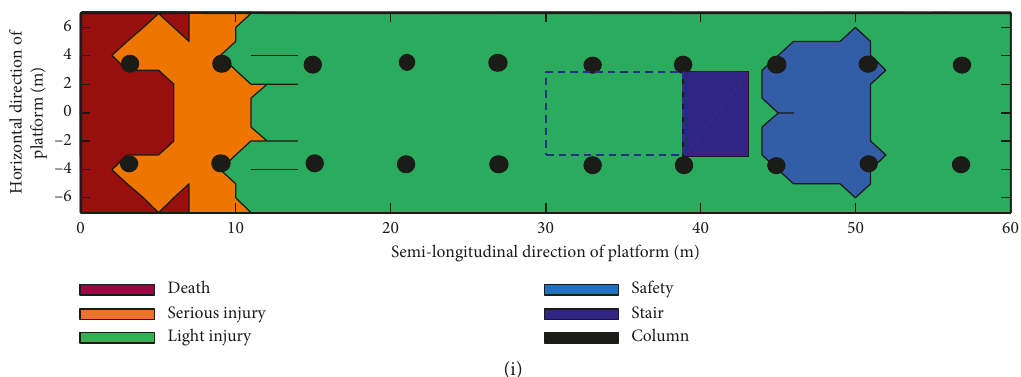
Figure 11: Distribution map of casualties. (a) 5kg TNTexploding at the center of the platform. (b) 10 kg TNTexploding at the center of the platform. (c) 20kg TNT exploding at the center of the platform. (d) 40 kg TNT exploding at the center of the platform. (e) 40kg TNT exploding at the edge of the platform. (f) 40kg TNTexploding at the entrance to the stair. (g) 40kg TNTexploding on the platform with half- height shield door. (h) 40kg TNT exploding on the platform with full-height and semiclosed shield door. (i) 40kg TNT exploding on the platform with full-height and fully closed shield door. Table 4: Casualty distance of personnel for explosion in subway platform. Subway